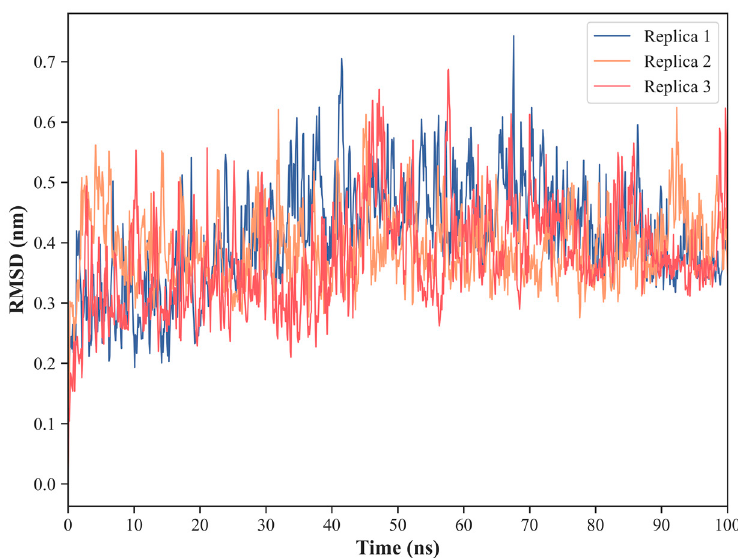
Figure 6. C α atoms root mean square deviation (RMSD) calculated over the MD simulation trajectories for the complex between the effector domain (ED) of NS1 and the iSH2 domain of the p85 β subunit of human PI3K (PDB ID: 6OX7).